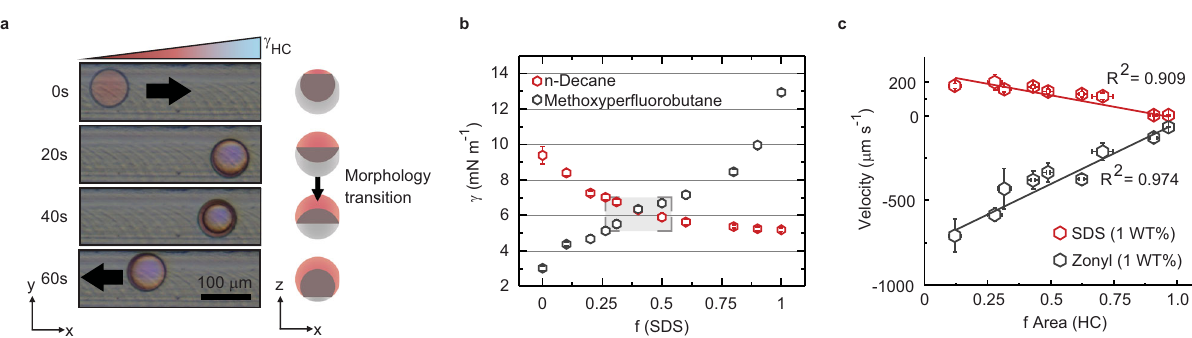
Fig. 3 Adaptive chemotactic motile behavior of recon fi gurable Janus droplets. a Top-view time sequence micrographs of a Janus droplet with a fl uorocarbon dominant morphology moving away from an added pure AOT surfactant solution nearing the point where the competitive Marangoni-type fl uid fl ows on the upper and lower hemisphere of the droplets become equal, and the droplet becomes stationary. A surfactant-induced recon fi guration of the droplet morphology then leads to reversal of the direction of chemotactic motion as a result of the fl uid fl ows adjacent to the hydrocarbon phase becoming dominant.; b pendant drop tensiometry measurements of the interfacial tensions of n-decane and methoxyper fl uorobutane in overall 1 wt.% solutions of the surfactants SDS and Zonyl in varying ratios; c velocities of Janus droplets in different morphologies moving in response to the addition of